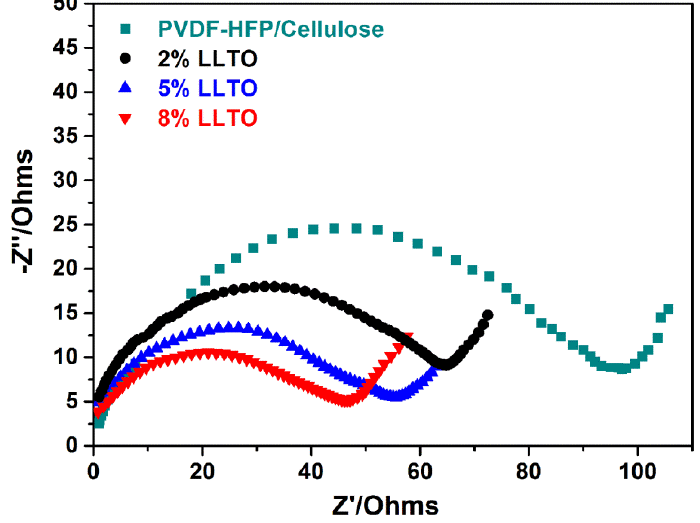
Figure 6. AC impedance spectra of Li/electrolyte ‐ soaked separator/Li cells at 20 °C.